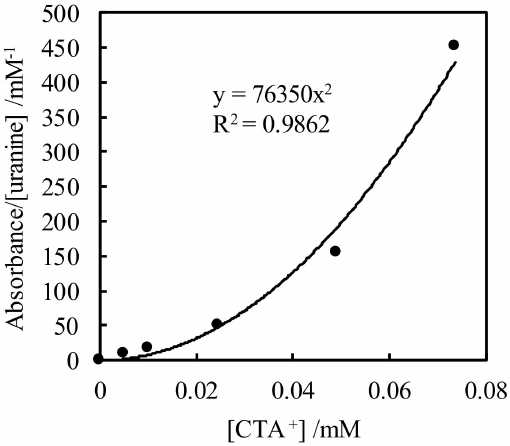
Figure 2. Plot of absorbance / [uranine] vs. the equilibrium concentration of CTA +